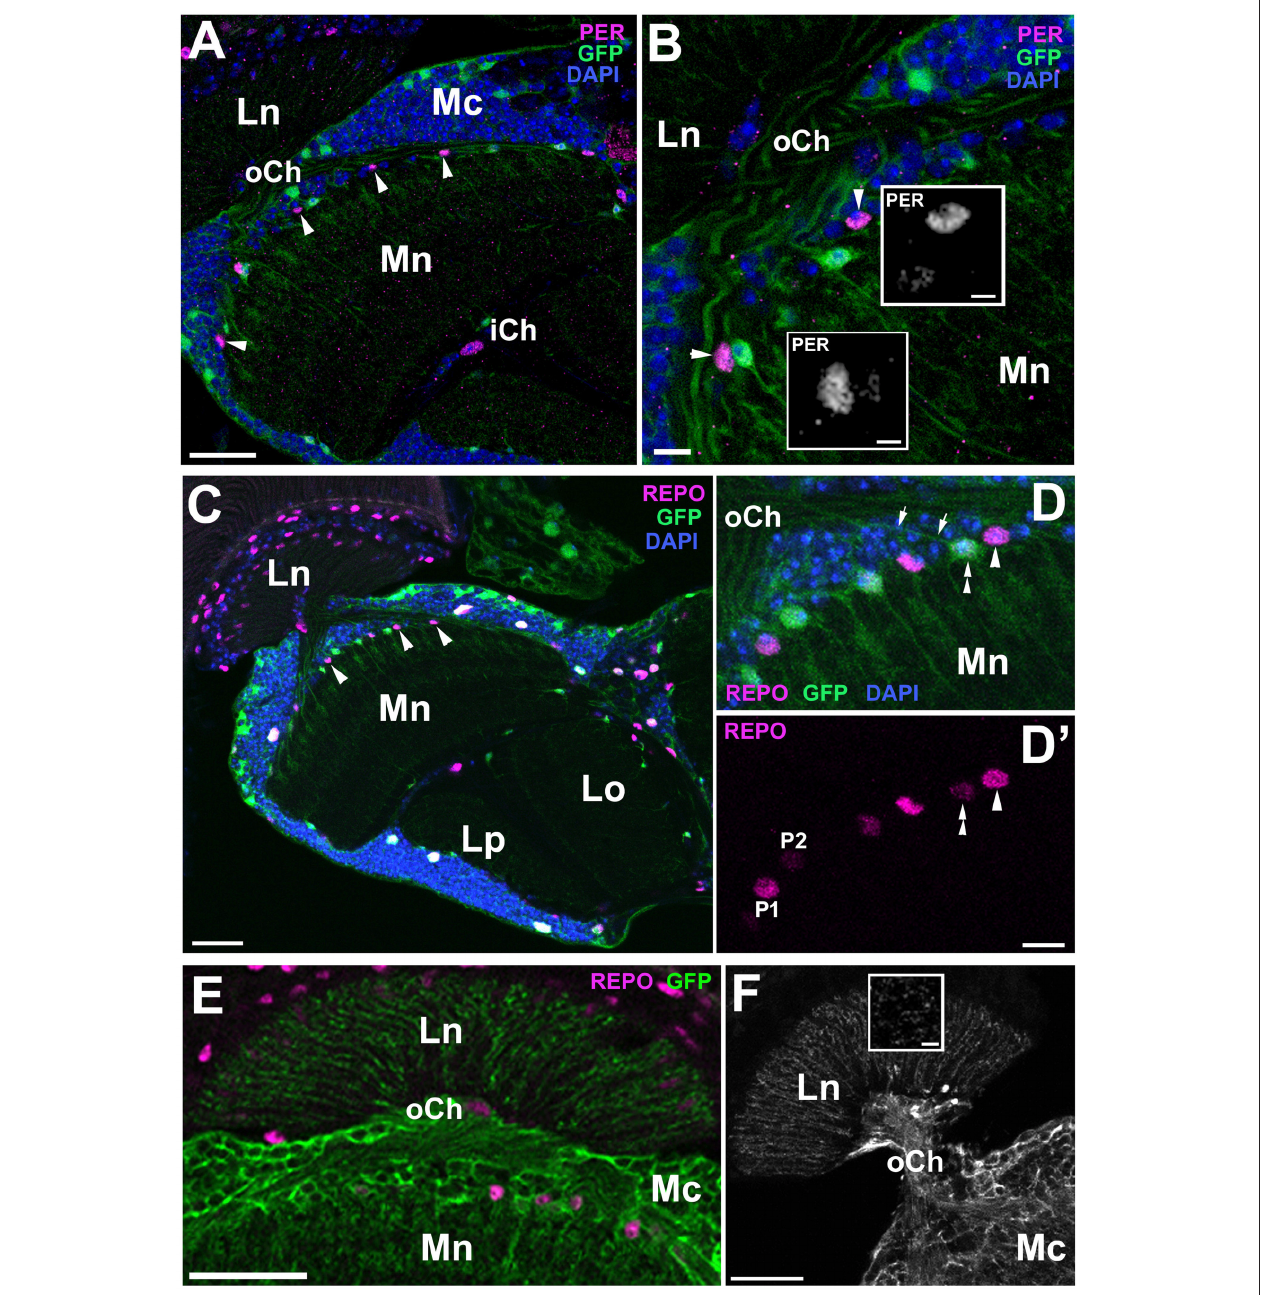
FIGURE 5 | Frontal sections of the optic lobe of EAAT1 -Gal4/UAS-S65T-GFP and EAAT1 -Gal4/UAS-mCD8-GFP transgenic flies collected at ZT1 and immunolabeled with anti-PER and anti-REPO antibodies. (A) PER-positive nuclei of the dMnGl (arrowheads) are clearly visible in the distal part of the medulla neuropil (Mn) of EAAT1 -Gal4/UAS-S65T-GFP flies. Ln, lamina neuropil; oCh, outer chiasm; Mc, medulla cortex; iCh, inner chiasm. Scale bar: 20 µ m. (B) Higher magnification of the distal medulla showing that GFP-positive cells express PER (inserts) at barely detectable level. The neighboring GFP-negative cells (arrowheads) express PER at high level. Scale bar: 5 µ m and 2 µ m (in inserts). (C) REPO-positive nuclei of the dMnGl (arrowheads) are well visible in the distal part of the medulla neuropil (Mn) of EAAT1 -Gal4/UAS-S65T-GFP flies. Ln, lamina neuropil; Lo, lobula; Lp, lobula plate. Scale bar: 20 µ m. (D,D’) Higher magnification of the distal medulla neuropil (Mn) of EAAT1 -Gal4/UAS-S65T-GFP flies viewed in a projection of 10 µ m thick image stack. GFP-negative cells (arrowhead in D ) express REPO at higher level (arrowhead in D’ ), whereas GFP-positive cells (double arrowhead in D ) express lower level of REPO (double arrowhead in D’ ). Some of GFP-positive cells send projections to the lamina (arrows in D ). DAPI-positive nuclei visualize the medulla cortex. oCh, outer chiasm. Scale bar: 5 µ m. (E,F) Morphology of GFP-positive processes in the lamina of EAAT1 -Gal4/UAS-mCD8-GFP flies in frontal (E) and horizontal (F) sections. The basket-like terminals, which surround each of the lamina synaptic units, so called cartridges, are characteristic for the processes of T1 interneurons. Insert in (F) shows the cross section of T1 processes in the lamina. Ln, lamina neuropil; oCh, outer chiasm; Mc, medulla cortex; Mn, medulla neuropil. Scale bars: 20 µ m for (E,F) , 5 µ m for insert.